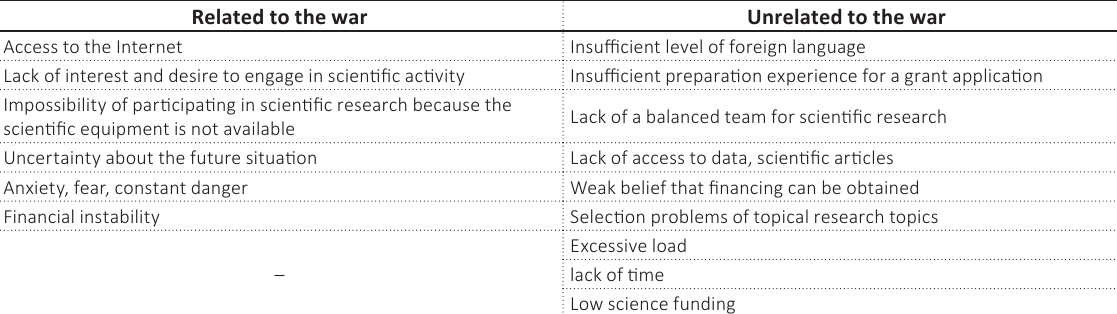
Table 3. Factors that influence scientific